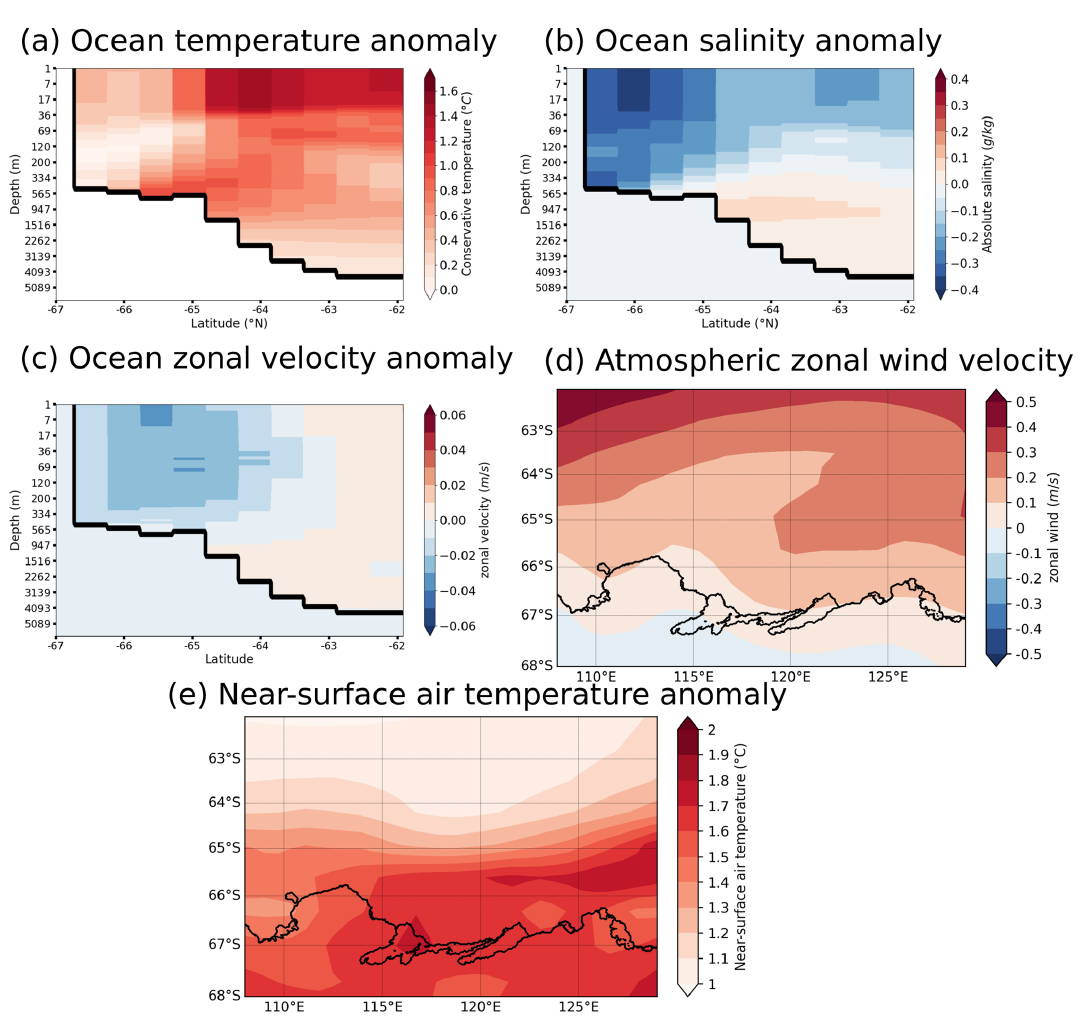
Figure 3. Annual mean EC-Earth3 anomalies applied at the eastern boundary of the model domain for the conservative temperature (a) , absolute salinity (b) and the zonal component of the ocean velocity (c) . Annual mean EC–Earth3 anomaly of the wind velocity (10m) zonal component (d) and the near-surface (2m) air temperature (e) . The anomalies are computed between the 2081–2100 and the 1995–2014